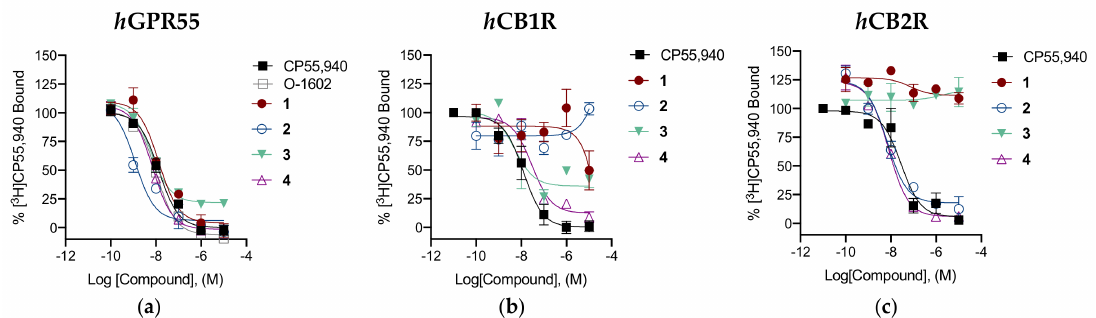
Figure 4. In vitro characterization of [ 3 H]CP55,940 binding in the presence of compounds 1 – 4 at h GPR55 ( a ), h CB1R ( b ) or h CB2R ( c ). Data are expressed as % change from 1 nM [ 3 H]CP55,940 binding and are means ± SEM ( n = 3–4). All data were fit to a 3-parameter non-linear regression in GraphPad (v. 9.0). Analyses are presented in Table 1.